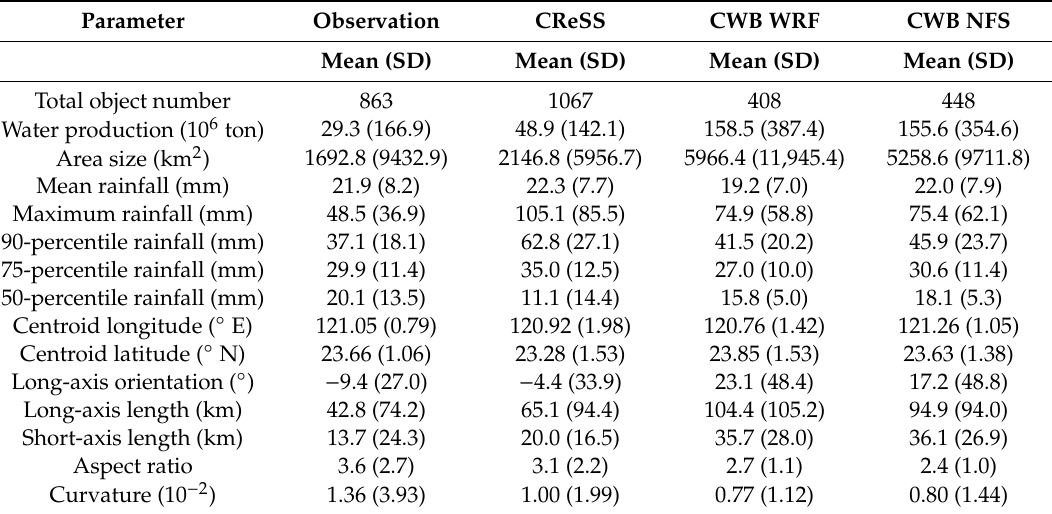
Table 3. As in Table 2 but showing the results for observation and model forecasts corresponding to the initial time of 1200